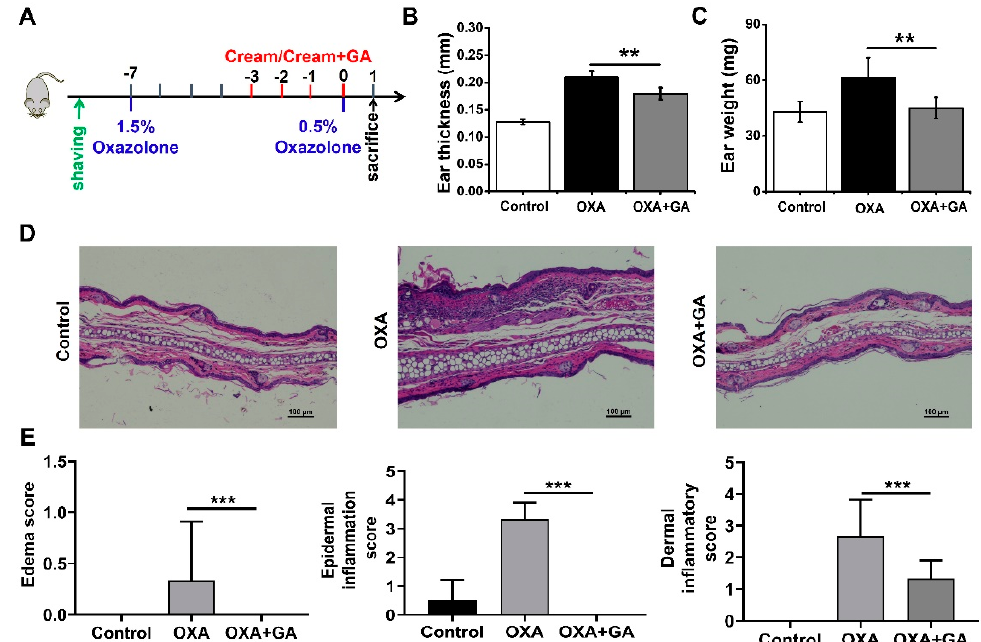
Figure 4. Effect of Au nanoclusters on skin inflammation and keratinocyte abnormalities in oxazolone (OXA)-induced psoriasis. The mice were divided into three groups, n = 5 mice per group. ( A ) depicts a flowchart of the experimental protocol for the psoriasis model. Ear swelling was assessed by measuring ear thickness ( B ) and weight ( C ). Data are presented as the mean ± SD (n = 5); ** p < 0.01. ( D ) Images of the H&E staining of the ear of mice in each group treated with OXA or OXA+GA. Scale bar = 100 µm. ( E ) Histological score of inflammatory infiltration and edema in the ears of the mice. Data are presented as the mean ± SD (n = 3); *** p < 0.001.